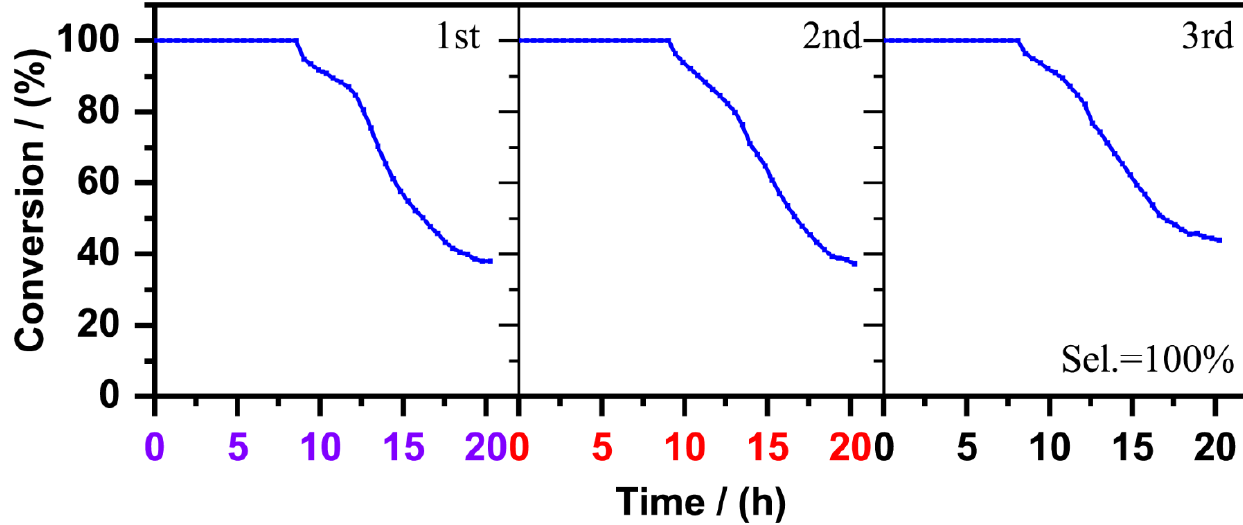
Figure 9. Catalyst 1.5Fe-Mo 2 C-550 reuse on toluene hydrogenation, 1st: after pretreatment, 2nd: regeneration after the first deactivation, 3rd: regeneration after the second deactivation. (The regeneration condition is the same as the pretreatment condition. Reaction conditions: 100 °C, WHSV: 0.15 h − 1 , pressure: 3 MPa).